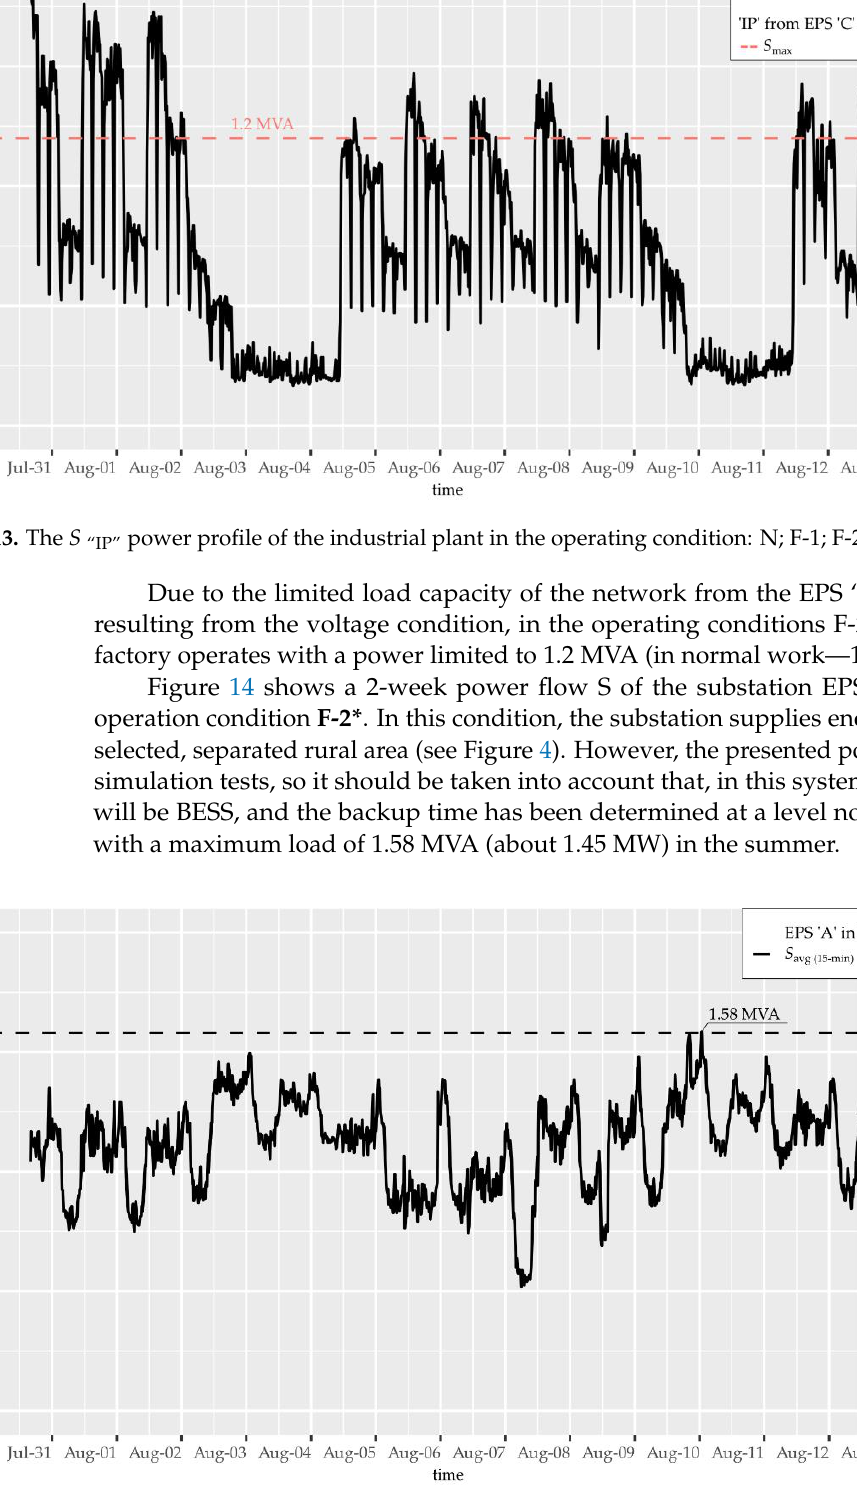
Figure 14. The S EPS “A” power profile of the EPS “A” substation in the failure operating condition F-2* . The distribution of the maximum power S max values in all the operating conditions at selected points of the considered networks is presented in Table 15.